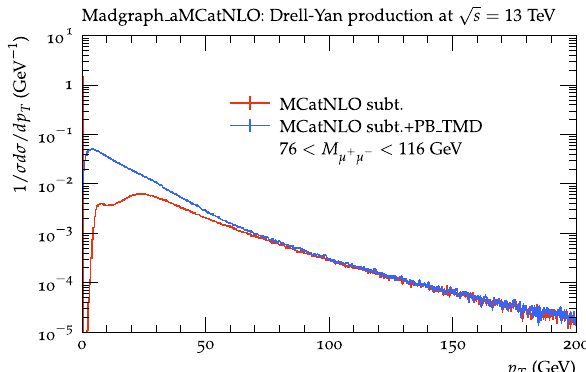
Fig. 4 TransversemomentumspectrumofZ productionatpartonlevel (LHE level) for subtraction terms and after inclusion of PB-TMDs at √ s = 13